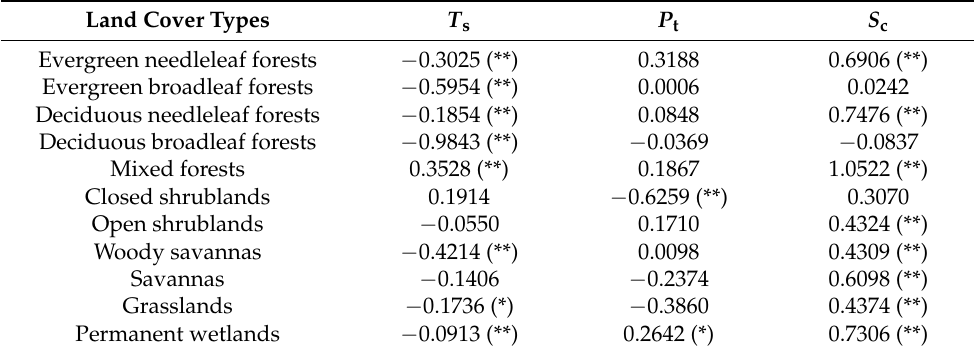
Table 2. Sensitivity of spring SOS to changes in T s , P t , and S c